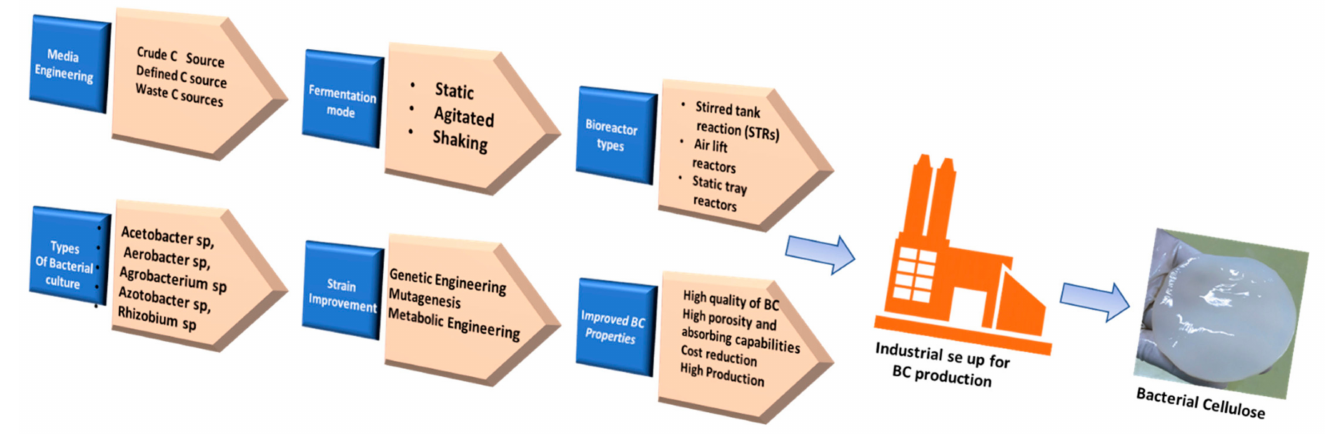
Figure 1. Illustration of various BC synthetic C sources, microbial strains, and synthetic strategies for high scale BC